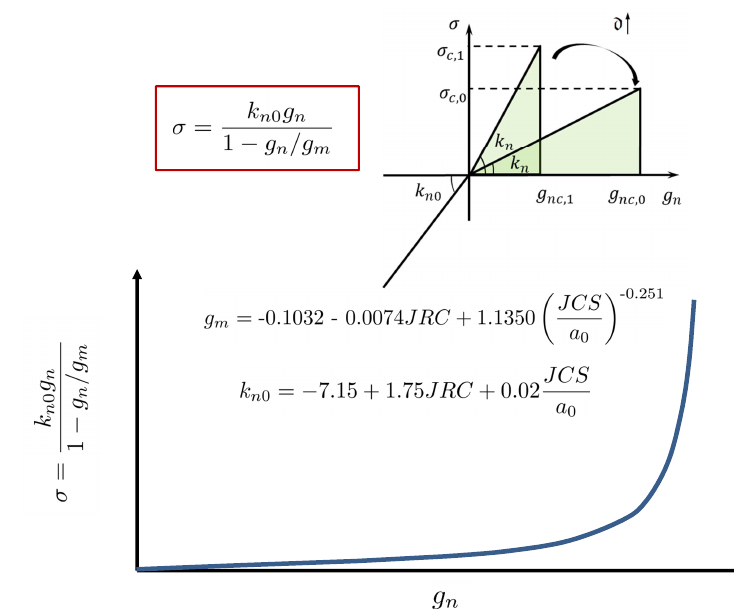
Figure 9. Modification of interface penalty stiffness under normal compression due to geo-mechanical aspects: schematic representation under negative normal gap g n